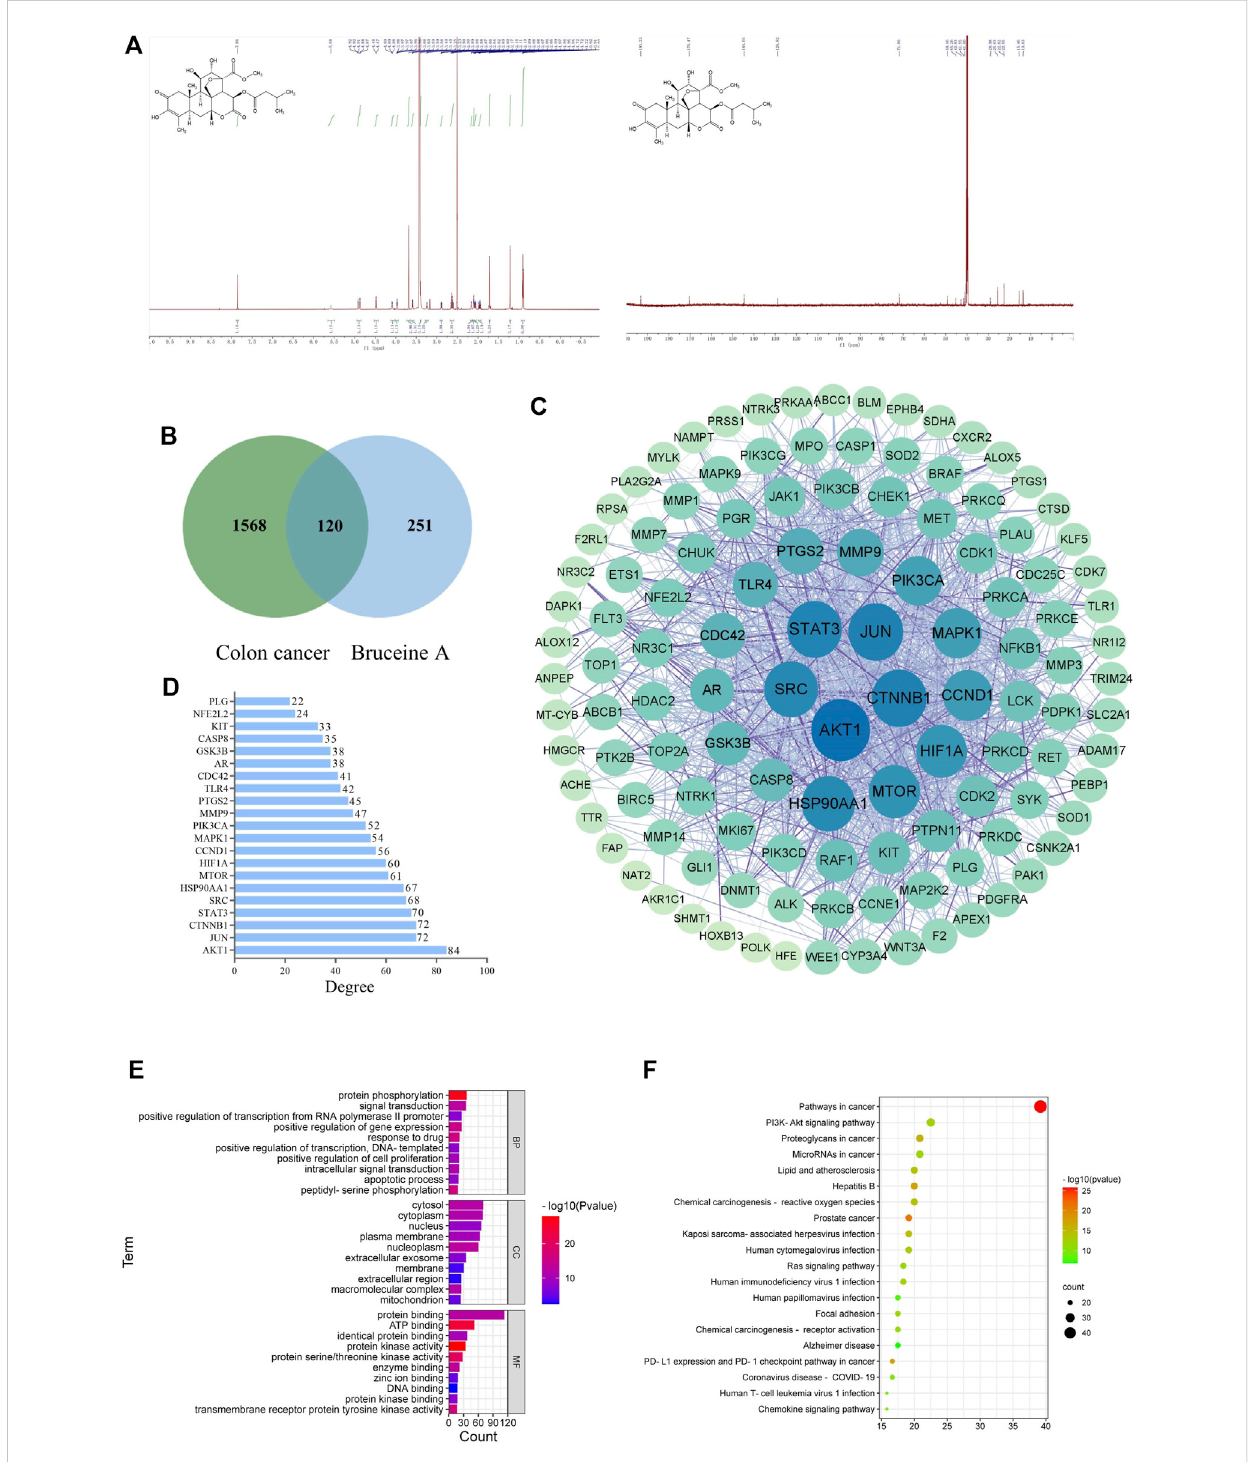
FIGURE 1 Network pharmacology analysis. (A) The chemical structure ofBruceine (A,B) Venn diagram ofBruceineA targets and colon cancer-relatedtargets. (C) PPI network of common targets of BA and CC. The larger the node and the darker the color is, which means the higher the degree of correlation. (D) Bar plot showing the top 21 hub genes in the PPI network. (E) The top 20 enriched KEGG pathways of target genes. (F) GO analysis of target